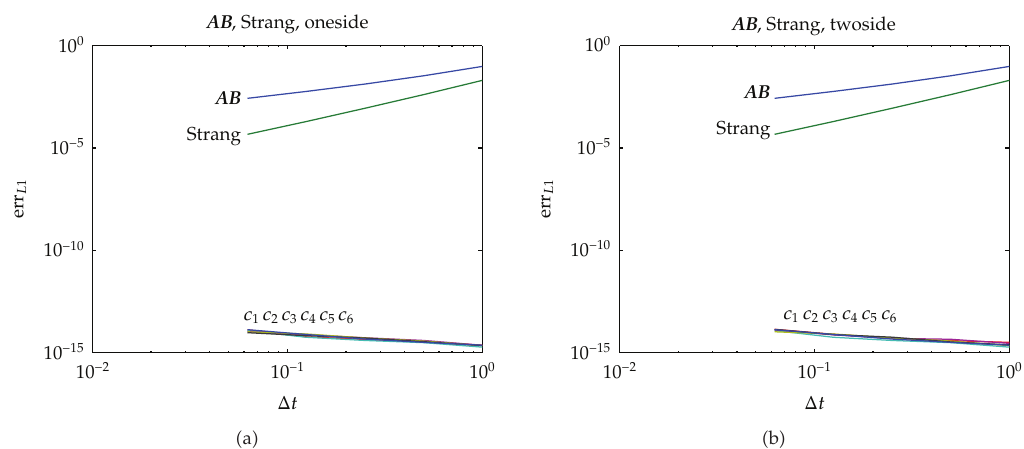
Figure 3: Numerical errors of the standard splitting scheme (cid:5) a (cid:6) and the iterative schemes (cid:5) b (cid:6) with 1 ,... , 6 iterative steps.